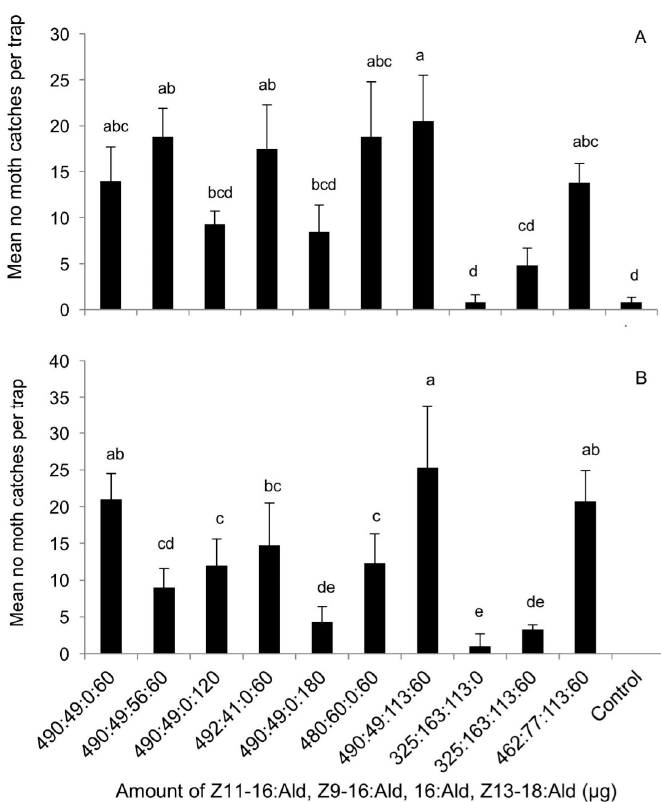
Figure 3. The average number of male Chilo suppressalis caught per trap per night in the rice fields in ( A ) Ningbo, Zhejiang (18 August–6 September 2010) and ( B ) Meishan, Sichuan (19 August–25 August 2010), by lures made up of single and mixed blends of the pheromone components Z11-16:Ald:Z9-16:Ald:16:Ald:Z13-18:Ald, in the ratios indicated along the x axis. Each treatment was replicated five times. Treatment bars represent the standard errors; the bars with different letters above them are significantly different from each other in the number of male moths captured ( p < 0.05). The third experiment that evaluated the effect of different doses of the blends in a ratio of 490:49:60 of Z11-16:Ald, Z9-16:Ald, Z13-18:Ald on trap catches demonstrated that the blends containing a total of 600 μ g and 150 μ g per lure would catch the highest number of moths. Larger amounts of this blend would decrease in overall attractiveness (DF = 10, F = 2.74, p = 0.02) (Figure 4). In the fourth experiment, the data suggested little geographic variation in the attractiveness of each mixture (Figure 5A–C). There was no statistically significant difference in the trap catches between the different pheromone treatments in Ningbo (DF = 7, F = 1.41, p = 0.23) or in Shaoyang (DF = 10, F = 1.33, p = 0.28). Amounts of Z11-16:OH and 18:Ald had no significant effect on moth catches. In Meishan, the effect of 16:Ald was difficult to interpret, but the overall difference in the number of moth catches was small (DF = 12, F = 2.6, p = 0.013).